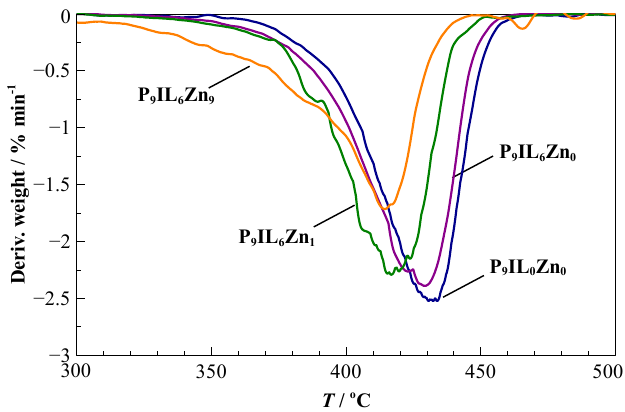
Figure 2. TGA spectra of P 9 IL 0 Zn 0 , P 9 IL 6 Zn 0 , P 9 IL 6 Zn 1 and P 9 IL 6 Zn 9 as functions of